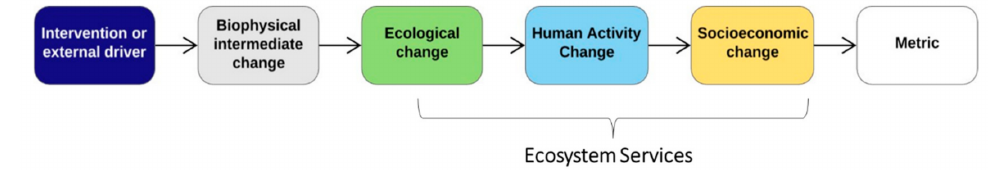
Figure 1. Ecosystem Services Conceptual Models show how a management intervention or external stressor or driver cascades through a natural system to have impacts on human activities and their social and economic wellbeing. The linkages between ecological change and socio-economic changes are the ecosystem